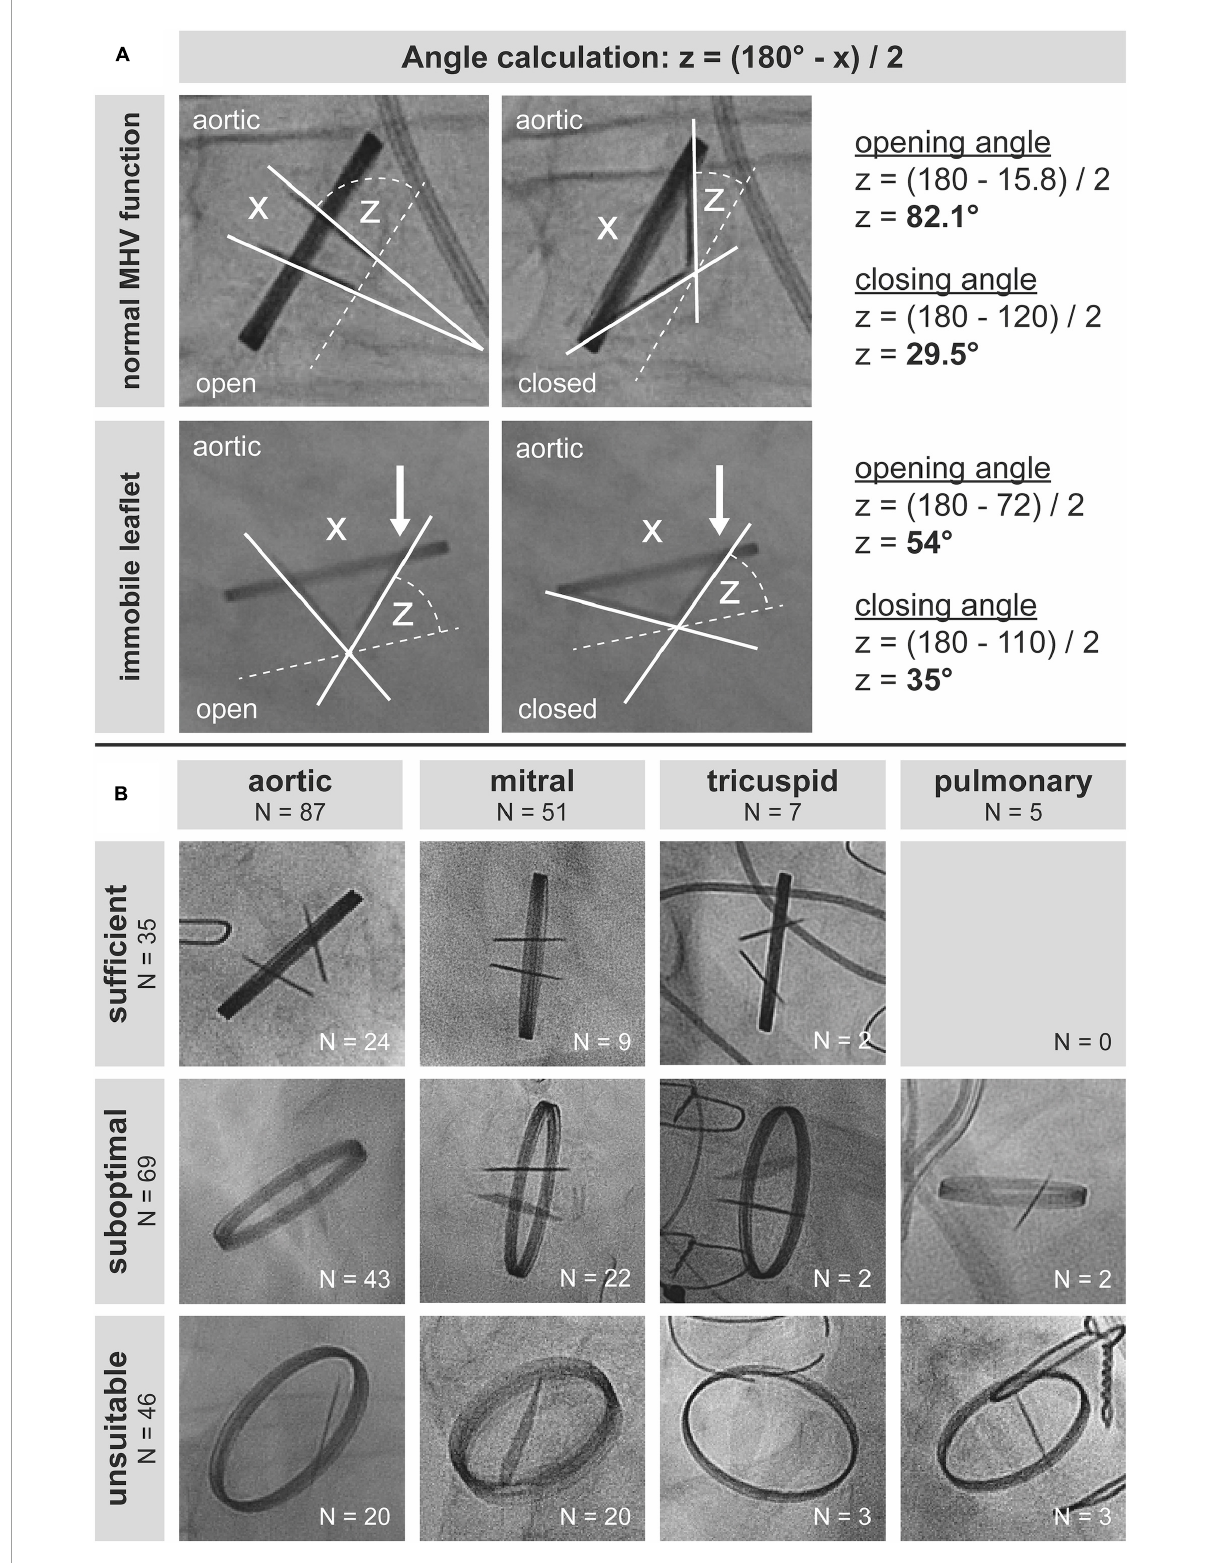
FIGURE1 Best practice and real-world practice of cinefluoroscopy of mechanical heart valves (MHVs). (A) Evaluation of leaflet function in two patients with a mechanical aortic valve prosthesis. Orthogonal visualization of leaflets with a perpendicular view of the ring without any parallax or oblique viewing is a prerequisite for accurate quantification of opening and closing angles. (B) Of 150 cinefluoroscopic valve investigations, only 35 allowed for quantification of opening and closing